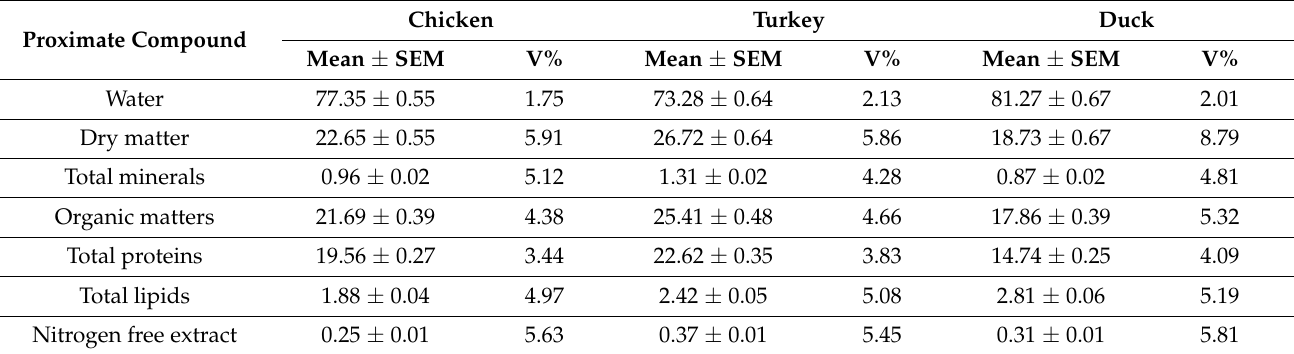
Table 1. Proximate composition of the matured poultry meat prior to smoking (g/100